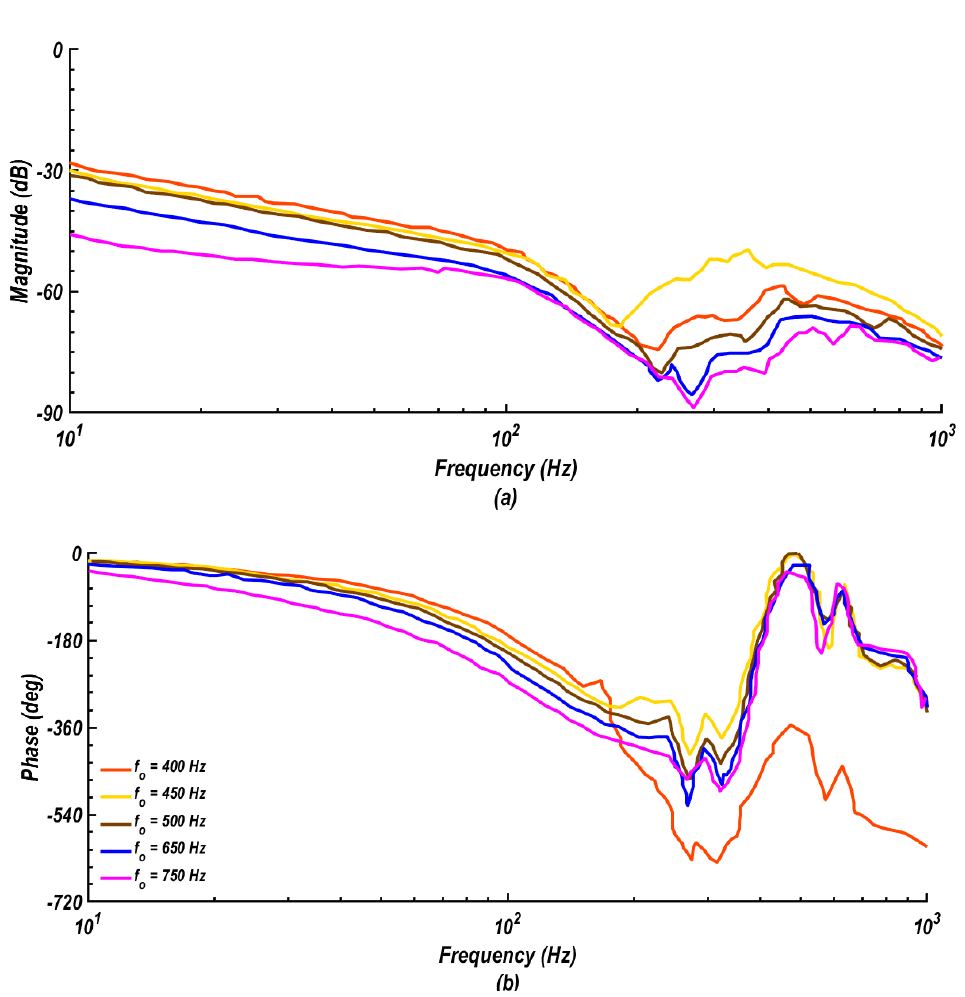
Figure 17. A set of frequency responses of the linearized plant. ( a ) Magnitude in decibel versus frequency in Hz. ( b ) Phase in deg versus frequency in Hz.